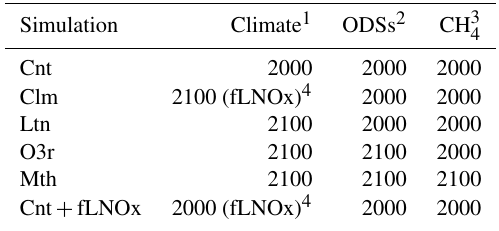
Table 1. Summary of the model